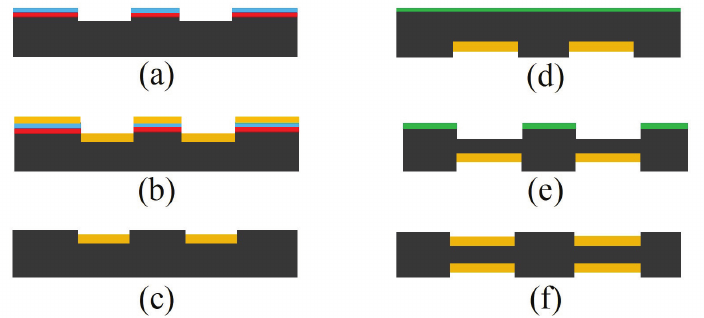
Figure 8. Schematic view of a QCM sensor fabrication steps ( a ) AT-cut quartz crystal of thickness of approximately 168–330 µ m is polished, followed by deposition of chromium layer, photolithography and wet etched steps, ( b ) Au layer of thickness of approximately 100–200 nm is deposited by electron beam evaporation, ( c ) gold electrodes are formed by lift-off process, ( d ) nickel layer is deposited using sputtering technique, ( e ) nickel layer is patterned and DRIE is carried out to transfer the pattern to the quartz, ( f ) electrodes are deposited using electron beam evaporation method followed by the lift-off